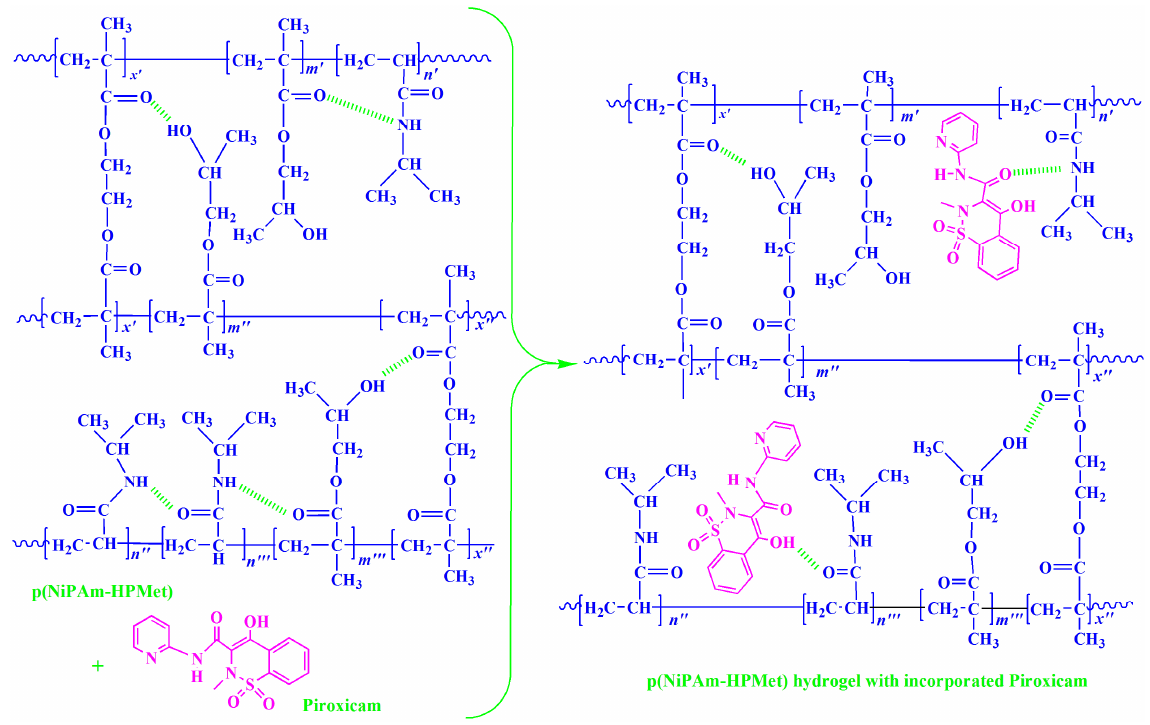
Figure 4. The piroxicam incorporation into the poly( N -isopropylacrylamide- co -2-hydroxypropyl methacrylate) hydrogels (the potential intramolecular interactions is indicated).